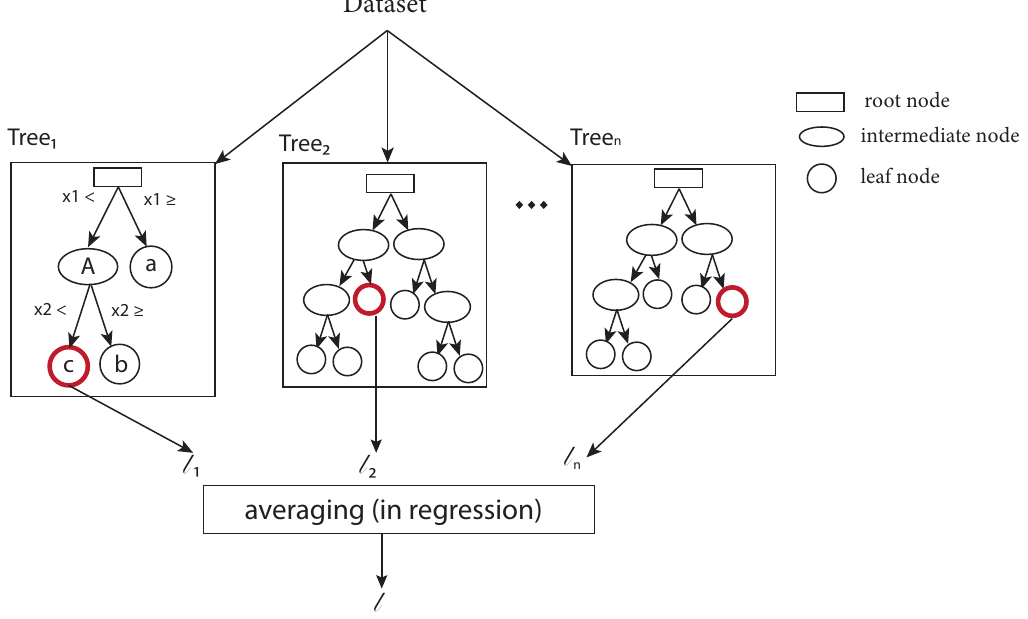
Figure 3. Basic structure of RF regressor: x = { x 1, x 2, ... } are features, n is the number of trees, l is the target value (after